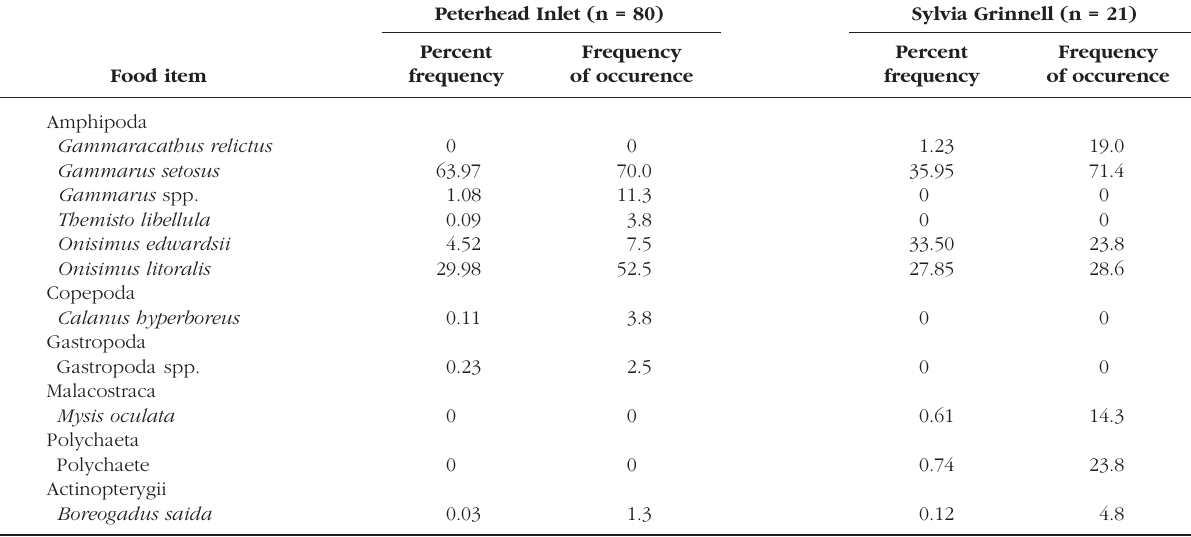
Table I. – Total percent frequency (%) and frequency of occurrence (%) of diet items in M. scorpius sampled from Peterhead Inlet and the Sylvia Grinnell River estuary,